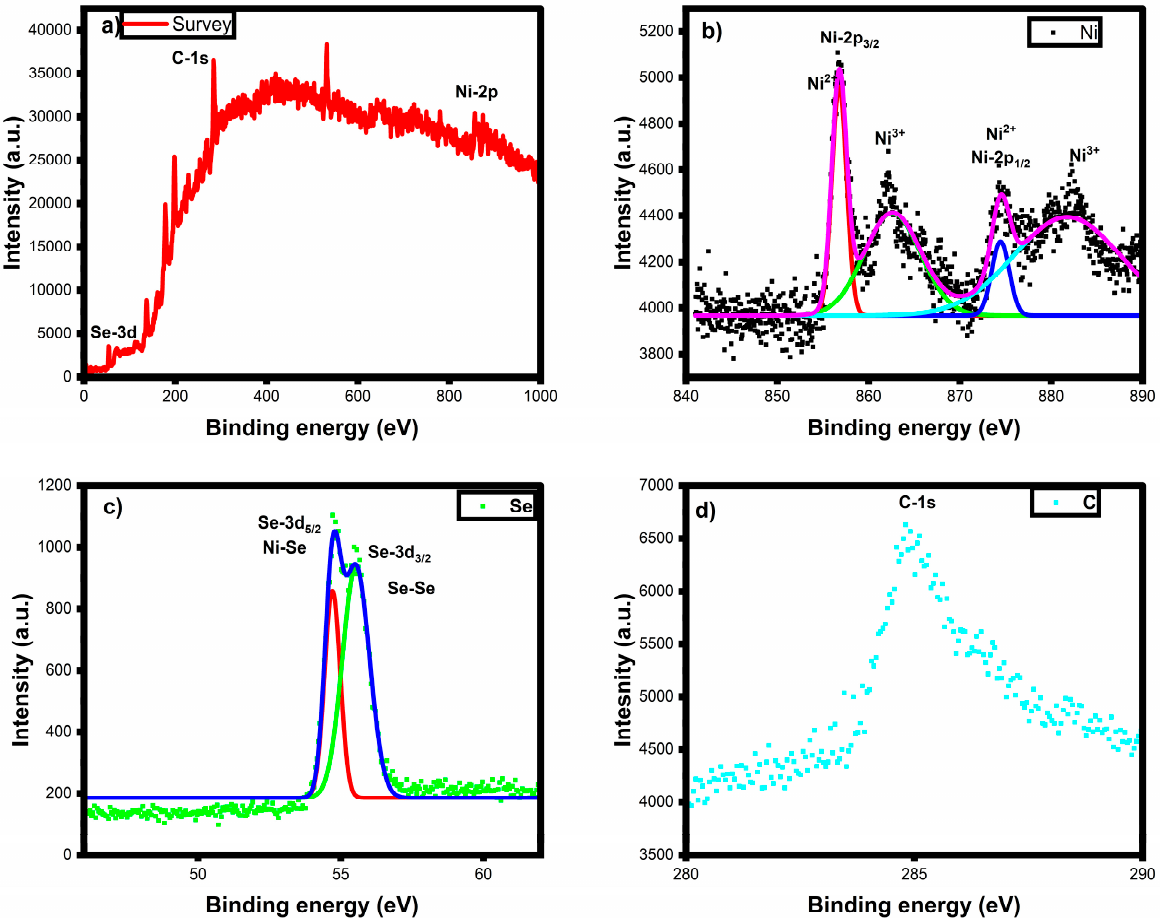
Figure 6. XPS survey ( a ), Ni-2p ( b ), Se-3d ( c ), C-1s (d) spectra of green synthesized NiSe